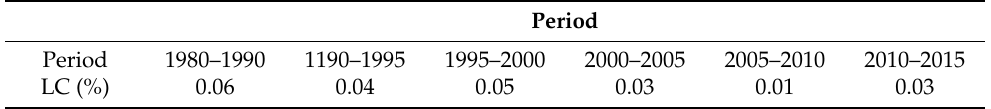
Table 3. The land use dynamic attitude (LC) from 1980 to 2015.